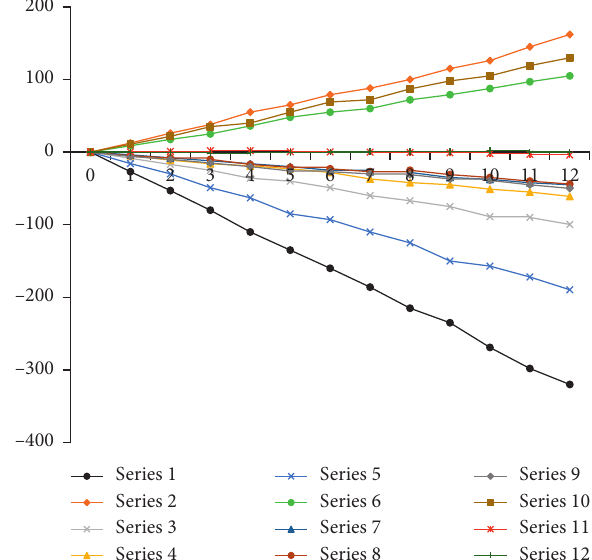
Figure 7: − 455m horizontal middle section 7# measuring point confining pressure constant curve.